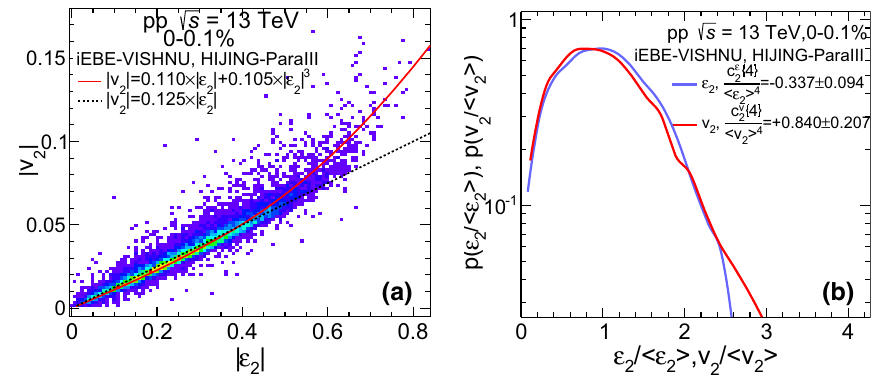
Fig. 5 Left panel: the scatter points between the v 2 and ε 2 , together with a linear fitting and a non-linear fitting with both linear and cubic terms. Right panel: the comparison between the scaled event-by-event ε 2 distribution and scaled v 2 distributions for iEBE-VISHNU simulations with √ HIJING initial condition (Para-III) at 0–0.1% p–p at s = 13